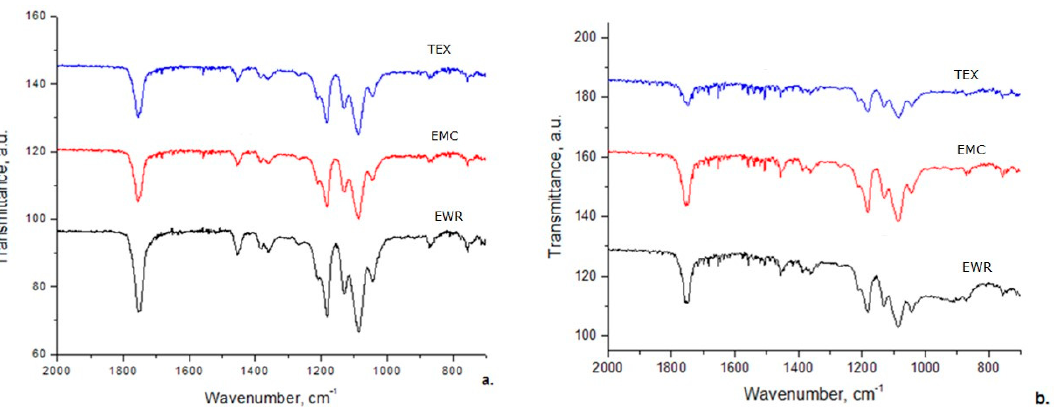
Figure 9. Fourier transform infrared (FT–IR) spectra of membranes: ( a ) before photocatalysis; ( b ) after photocatalysis.